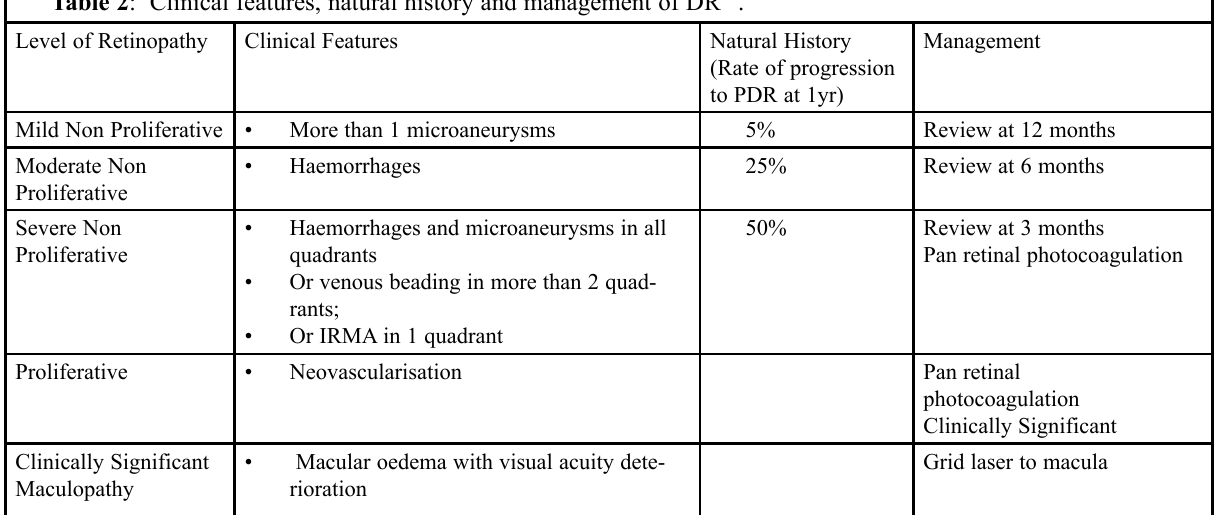
Table 2 : Clinical features, natural history and management of DR 24 . Level of Retinopathy Clinical